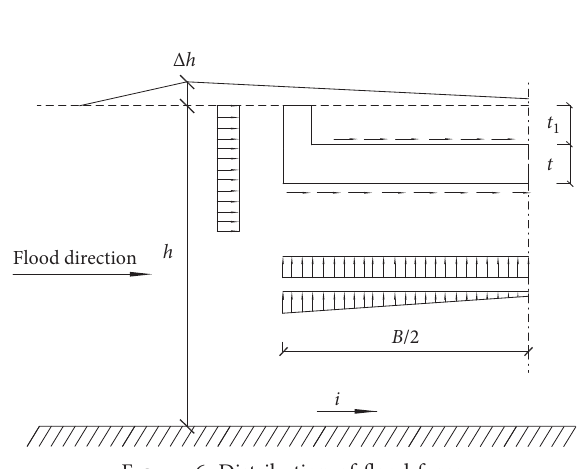
Figure 6: Distribution of flood force.